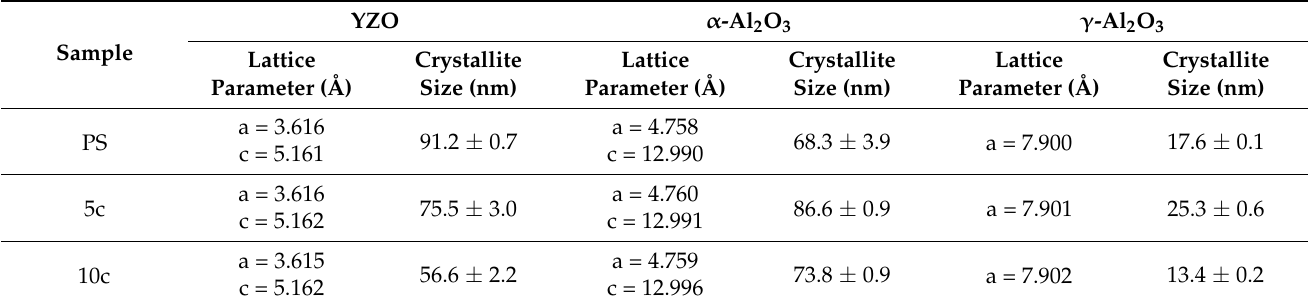
Table 2. Calculated microstructural parameters of the coating’s main crystalline phases.